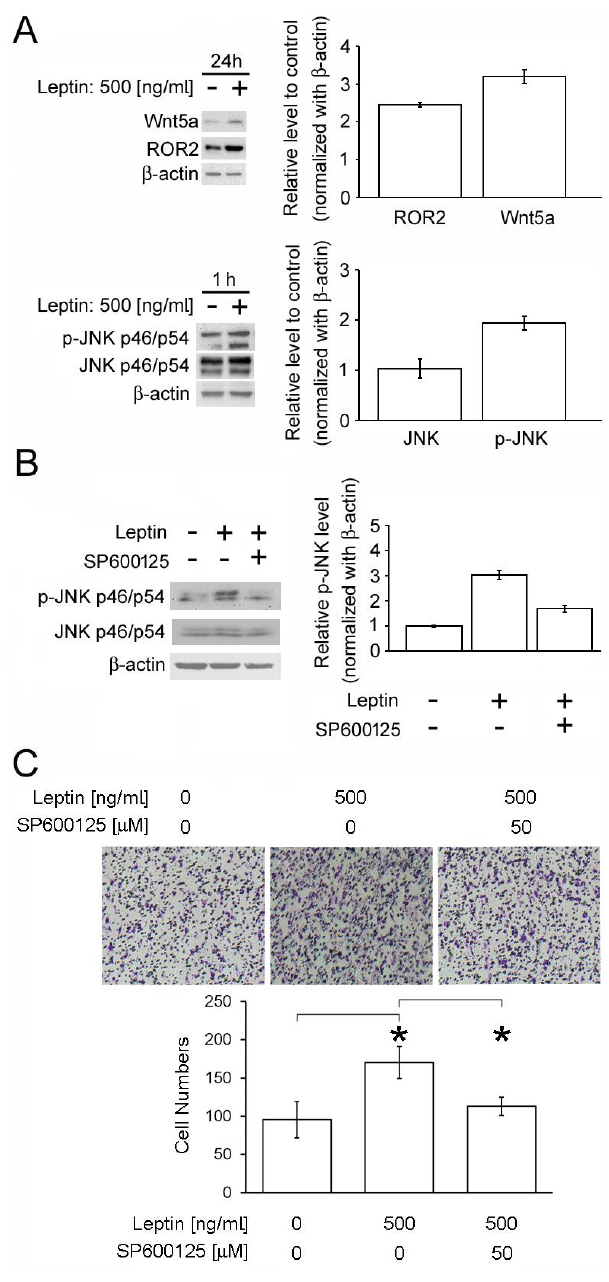
Figure 6. Induction of JNK phosphorylation activation and cell migration by leptin. ( A ) ACHN cells were treated with 500 ng/mL leptin for 1 and 24 h. The p-JNK at p46 and p54 isoforms and Wnt5a and ROR2 levels were detected by Western blot. ( B ) ACHN cells were pretreated with 50 μM SP600125 (a JNK inhibitor) for 30 min prior to 1 h of leptin incubation. Relative p-JNK level was evaluated by West- ern blot. ( C ) ACHN cells were pretreated with 50 μM SP600125 (a JNK inhibitor) for 30 min prior to 24 h of leptin incubation. Cell migration ability was measured by transwell assays. The experiments were performed three times and a representative result is shown. The p values at the following levels were considered significant: * p < 0.05.